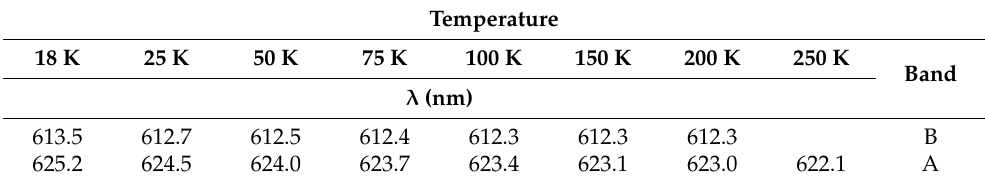
Table 4. Temperature dependence of the bands for ZnSe:Eu 3+ .